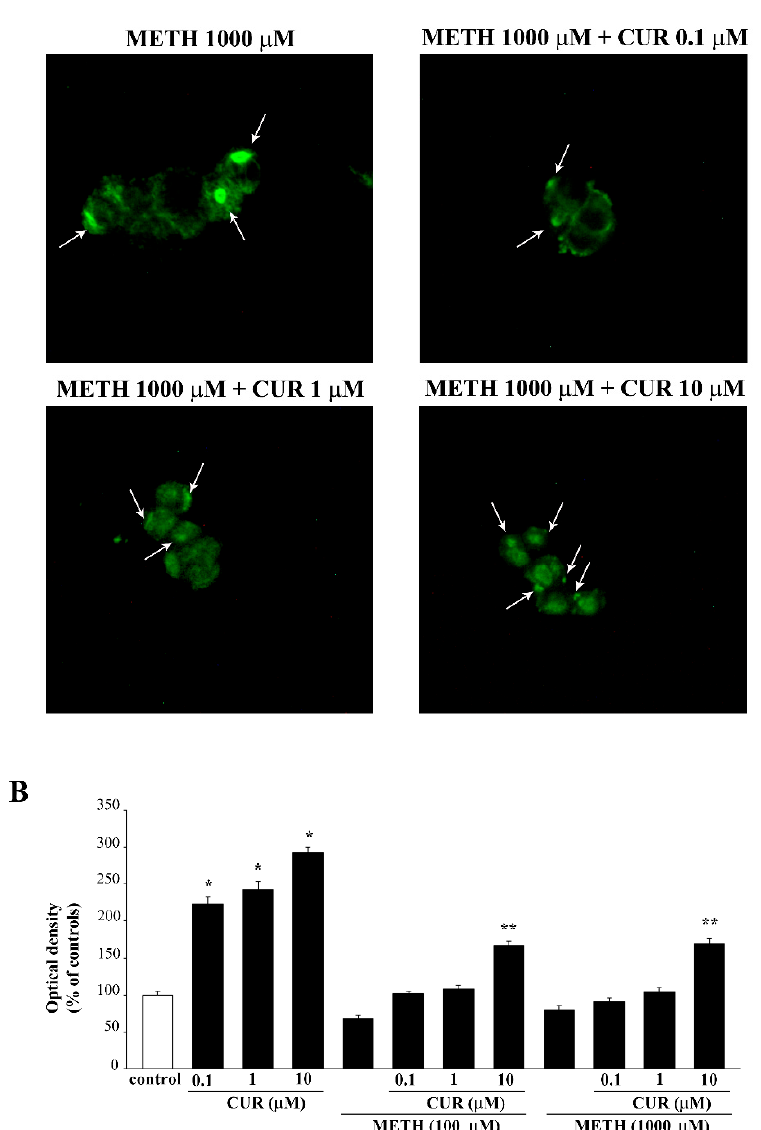
Figure 16. CUR increases LC3 immunofluorescence in control and METH-treated PC12 cells. ( A ) Immunofluorescence for LC3. Arrows indicate fluorescent puncta and bigger immunofluorescence agglomerates. ( B ) The graph reports the intensity of the immunofluorescence measured as optical density. * p < 0.05 compared with control; ** p < 0.05 compared with METH. Scale bar = 14.2 μ M.